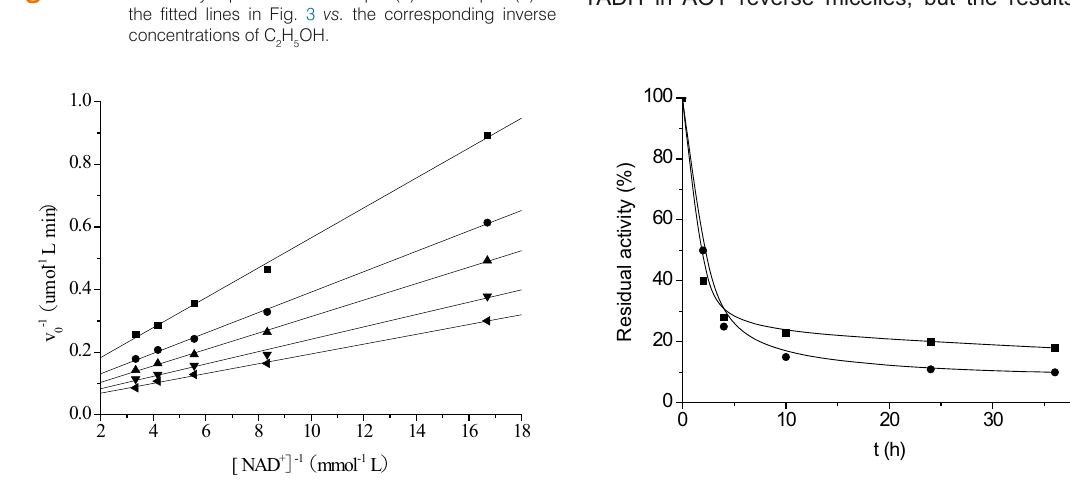
Figure 7. Time-dependent residual activities of YADH in GGDE/TX- Figure 5. Double reciprocal plot of the initial rate vs. the concentration 100 reverse micelle ( ■ ) and AOT reverse micelle ( ● of NAD + at different C H OH concentrations in AOT 2 5 reverse micelle. ω = 30, pH=8.0 and [C H OH] = 10 ( ■ ), 0 2 5 20 ( ● ), 30 ( ▲ ), 40 ( ▼ ), 50 ( ◄ ) mmol L -1 .